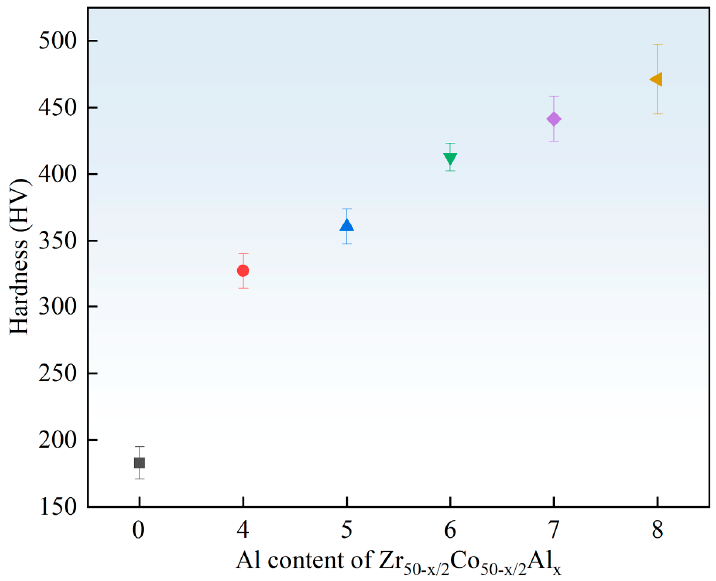
Figure 4. Vickers microhardness of Zr 50 − x/2 Co 50 − x/2 Al x (x = 0, 4, 5, 6, 7, 8) alloys.